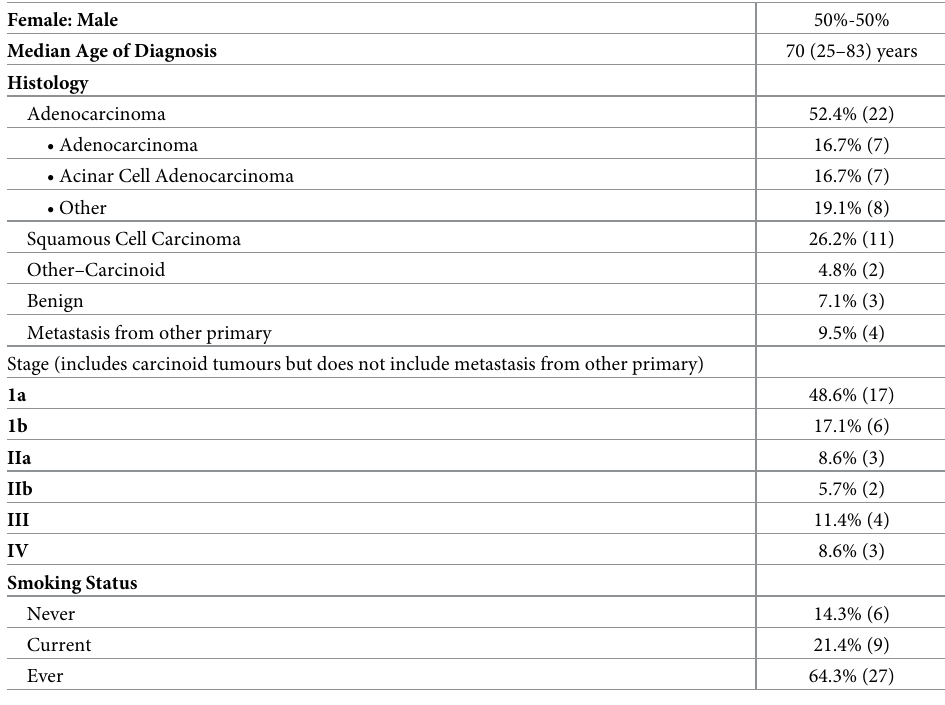
Table 1. Patient characteristics (N =